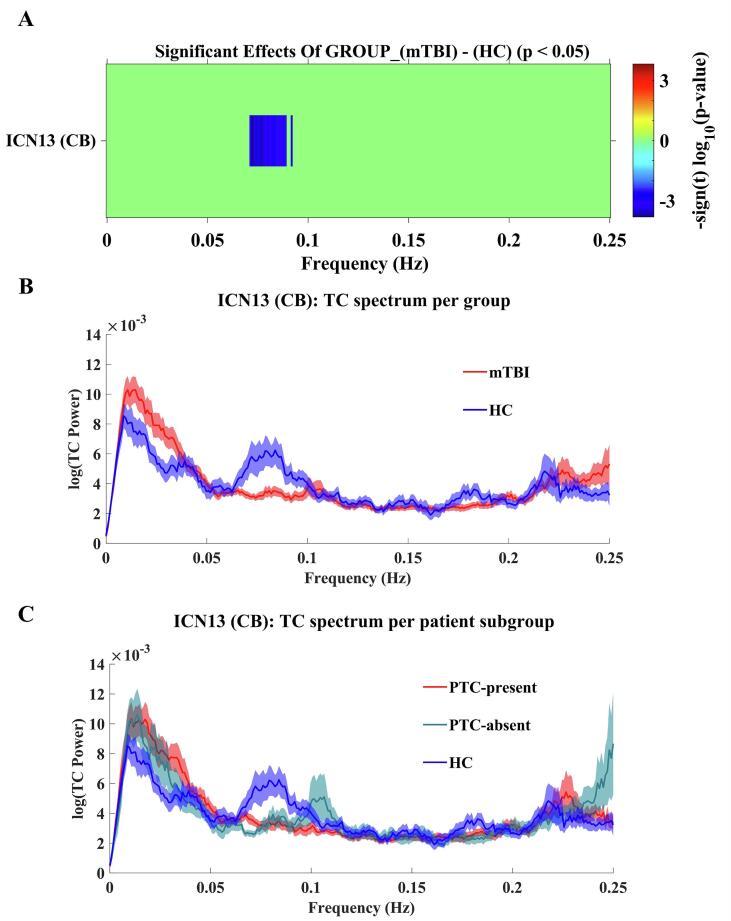
Effects of Group (mTBI vs. HC). (A): the color bar displays the significance and direction of the effects of group for ICN13 (cerebellar network) in the TC power spectrum (p < 0.05, FDR-corrected). (B): Line plots of the average TC power spectra for mTBI patients (mTBI; red) and healthy controls (HC; blue). C): Line plots of the average TC power spectra for mTBI patients with PTC-present (PTC-present; red), mTBI patients with PTC-abstent (PTC-absent; green) and healthy controls (HC; blue). The line plots show mean log(power) ± 1SE. (For interpretation of the references to color in this figure legend, the reader is referred to the web version of this article.)